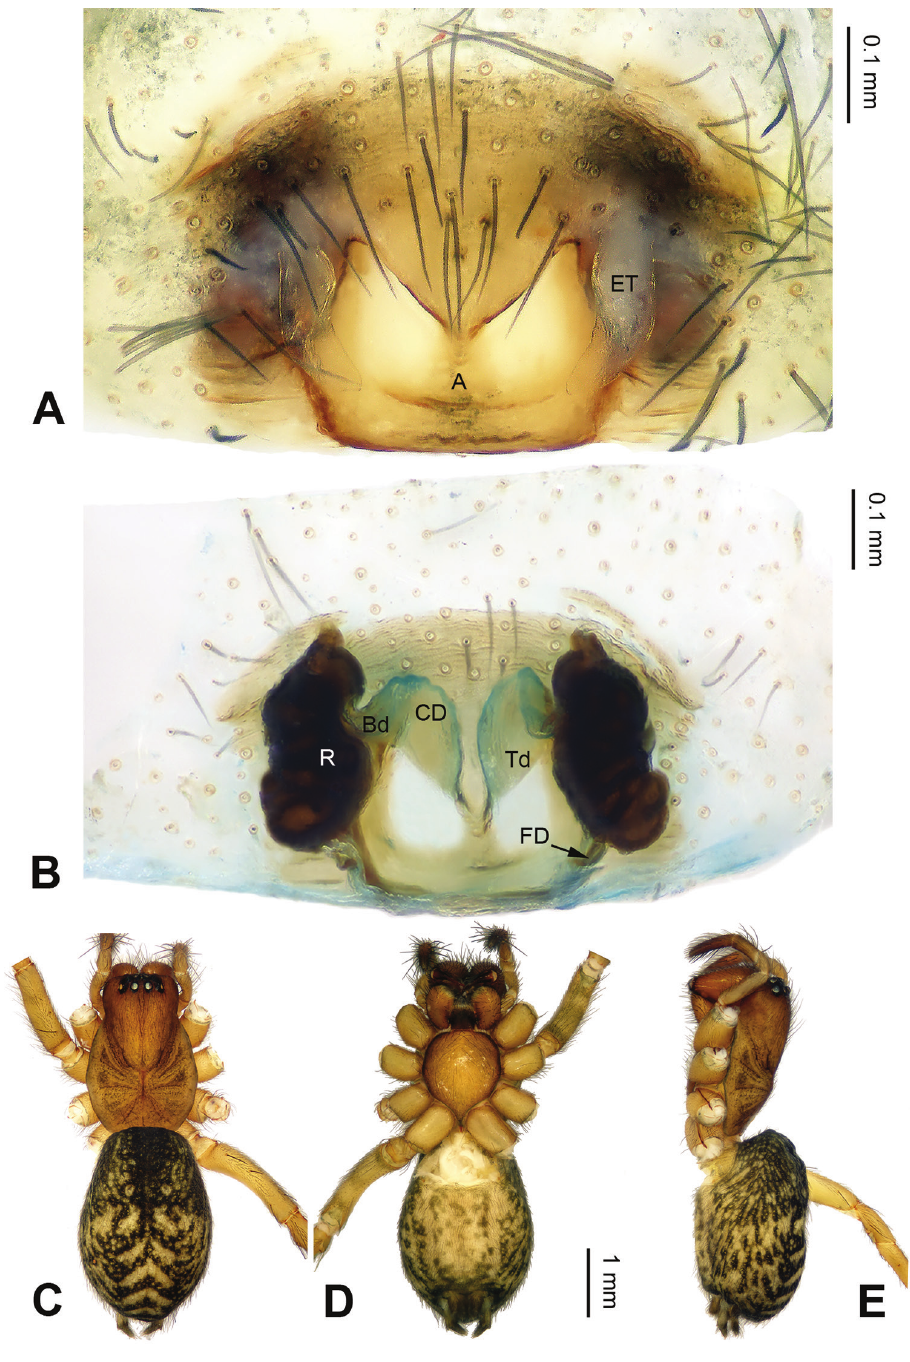
Figure 4. Pireneitega tyurai sp. n., female holotype. A Epigyne, ventral B Vulva, dorsal C Habitus, dorsal D Habitus, dorsal E Habitus, ventral. Scale bars equal for C, D, E